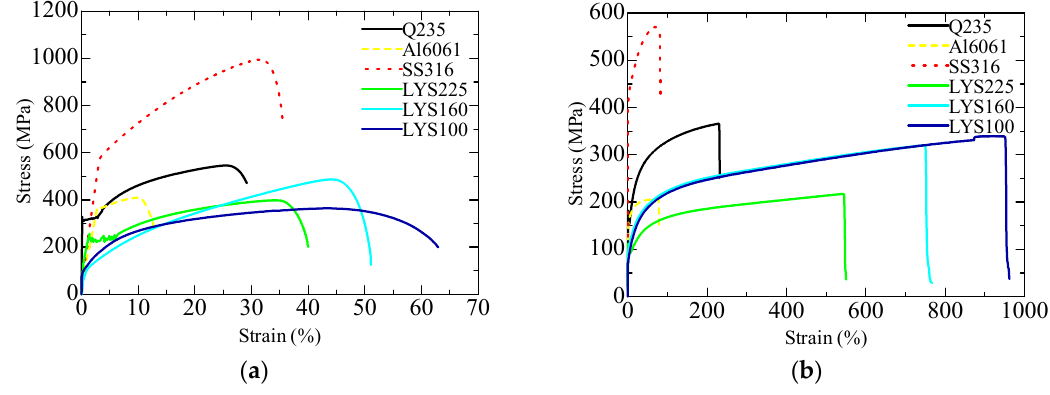
Figure 4. Stress–strain curves: ( a ) Tension test results; and ( b ) Torsion test results.